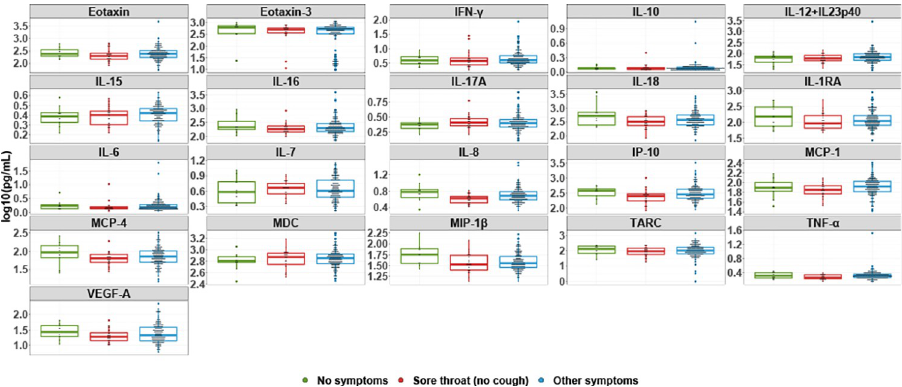
Fig 4. Cytokine and chemokine levels by symptom group. Log-transformed concentrations of cytokine and chemokines with � 80% detectability in the overall sample are shown. The median and inter-quartile range as well as all data points are presented. Individuals reporting no symptoms (n = 10), sore throat and no cough (n = 24), and all other symptoms (n = 182) are shown in green, red, and blue,